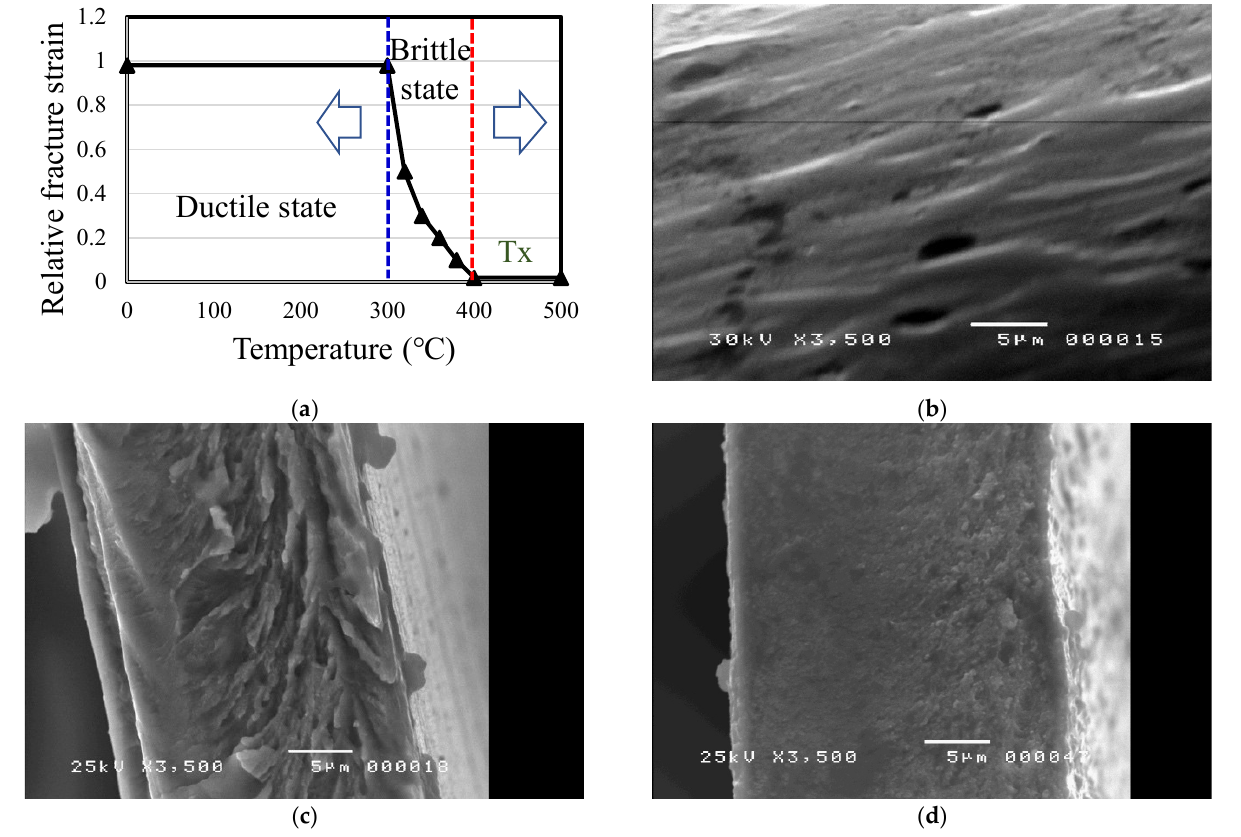
Figure 5. Measurement of the microstructure of material sample 3: ( a ) measurement of ductility and brittleness temperature range after annealing; SEM images at ( b ) 350 °C, ( c ) 390 °C, and ( d ) 450 °C.